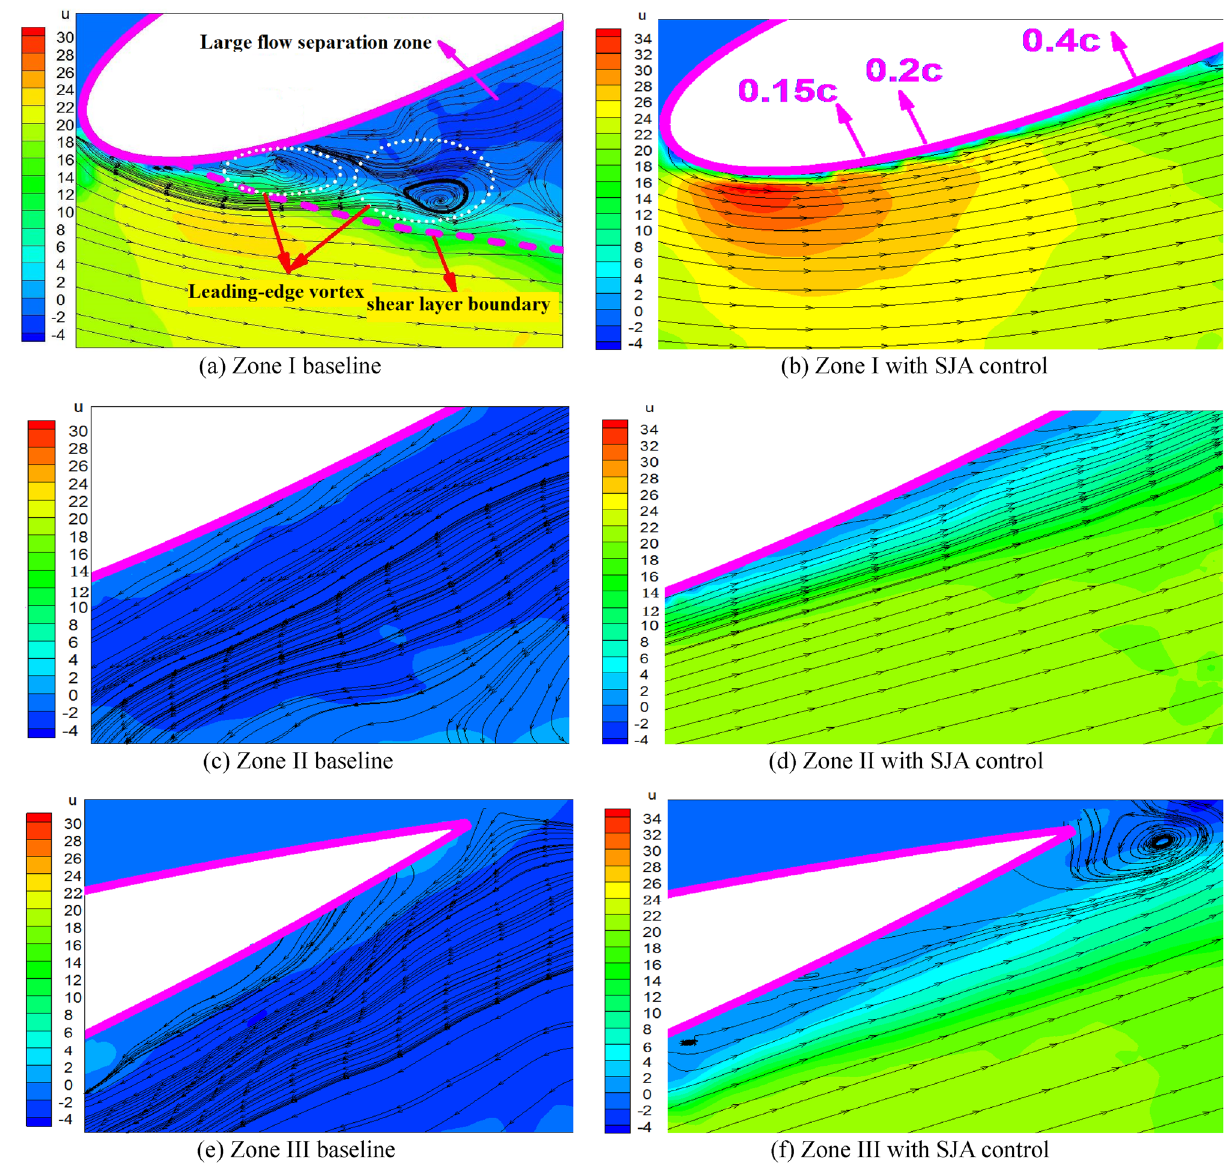
Figure 7. Velocity contours and streamline diagram of the airfoil under synthetic jet